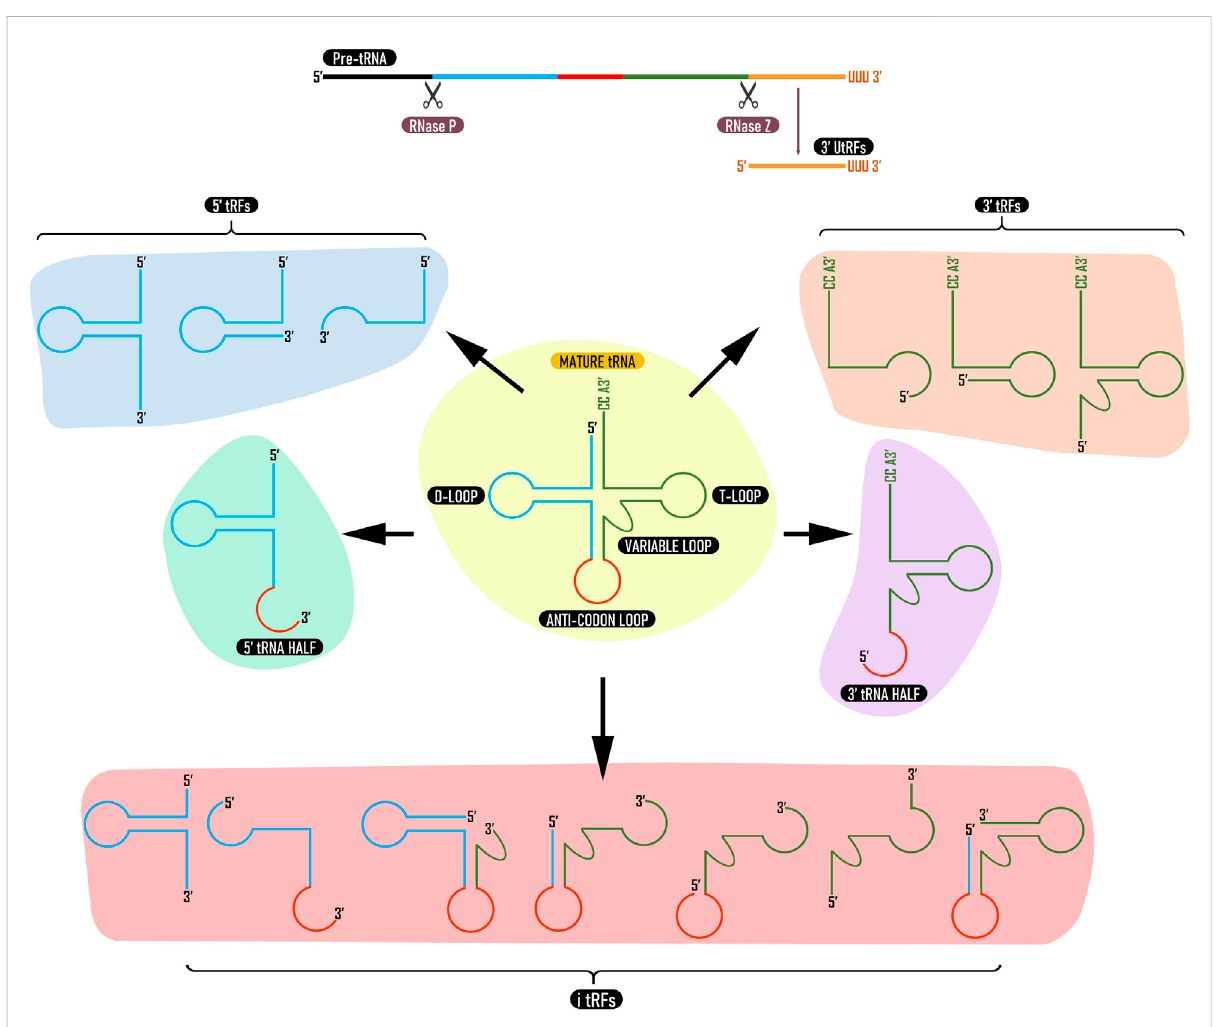
FIGURE 1 Types of tRNA derived fragments. tRFs can be derived from pre tRNAs (3 ′ UtRFs) or mature tRNAs (3 ′ tRFs, 5 ′ tRFs, i-tRFs, and tRNA halves). 3 ′ U tRFs are produced by cleavage of pre tRNA by RNase Z (or ELAC2). 3 ′ tRFs and 5 ′ tRFs are derived from 3 to 5 ′ ends of mature tRNA while i-tRFs are derived from internal regions. 3 and 5 ′ tRNA halves are produced by cleavage at the anticodon loop. tRFs from the same tRNA can vary in type and length depending upon tissue, developmental stage or environmental